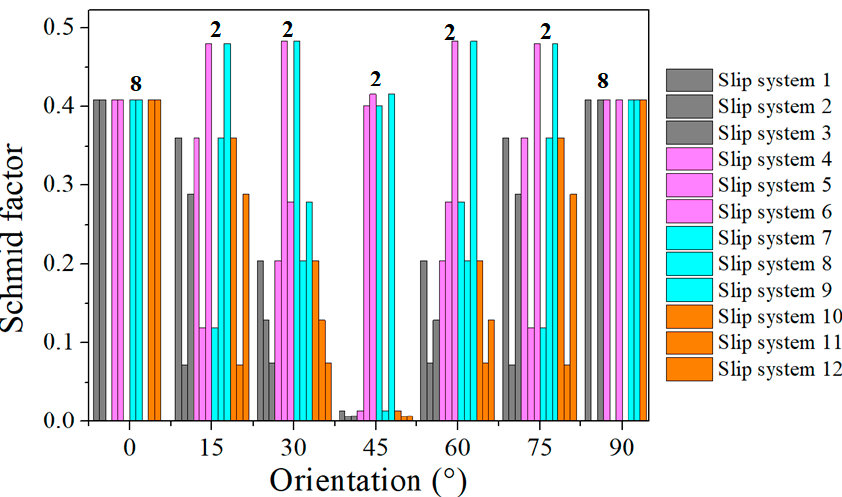
Figure 11. Calculation results of Schmid factors for slip systems of single grains with different orientations.